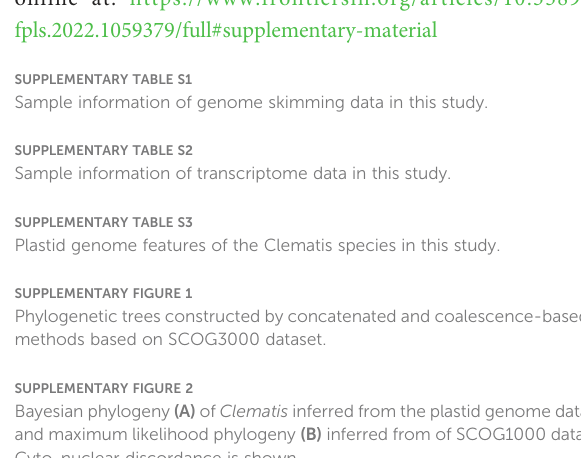
SUPPLEMENTARY TABLE S1 Sample information of genome skimming data in this study. SUPPLEMENTARY TABLE S2 Sample information of transcriptome data in this study. SUPPLEMENTARY TABLE S3 Plastid genome features of the Clematis species in this study. SUPPLEMENTARY FIGURE 1 Phylogenetic trees constructed by concatenated and coalescence-based methods based on SCOG3000